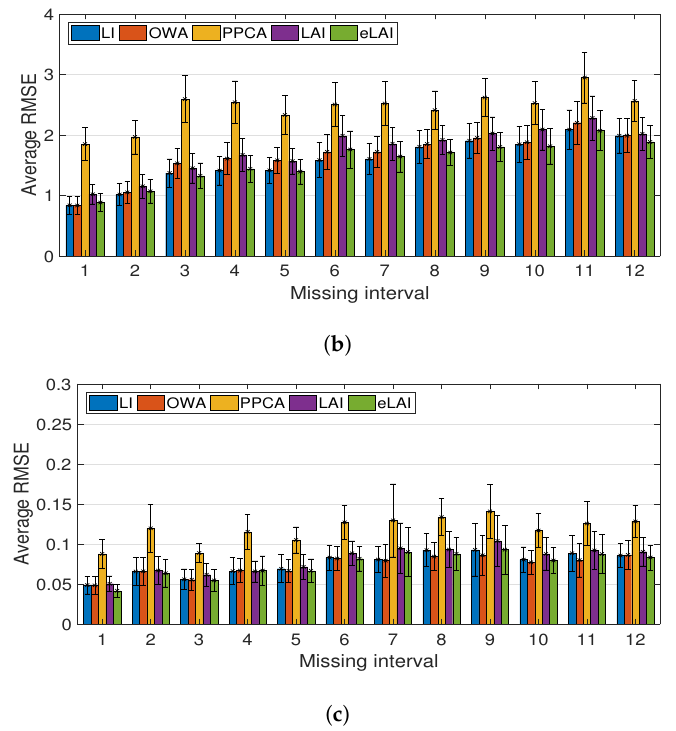
Figure 9. Average RMSE and 95% confidence interval of each method. ( a ) DOE; ( b ) KEPCO-high voltage; ( c ) KEPCO-low